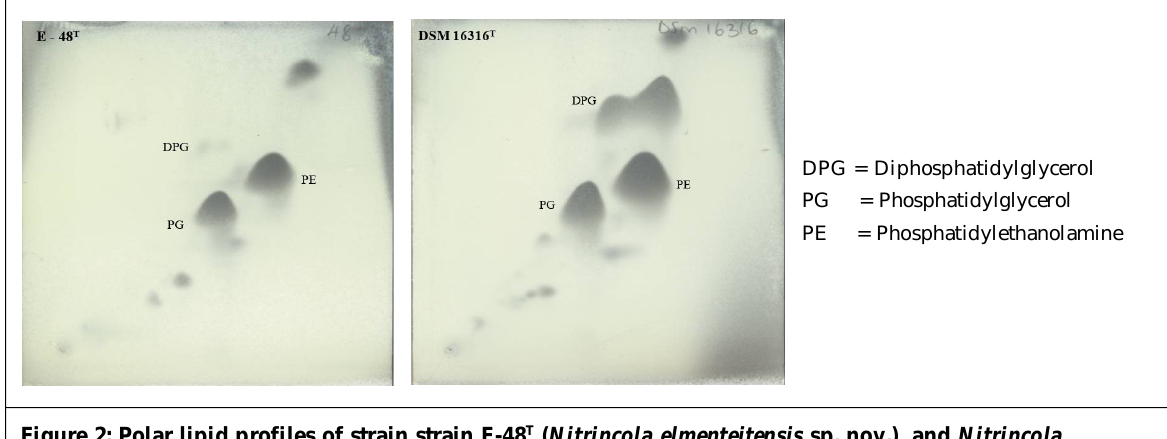
Figure 2: Polar lipid profiles of strain strain E-48 T ( Nitrincola elmenteitensis sp. nov.) and Nitrincola lacisaponensins DSM 16316 T after separation by two-dimensional TLC as described (Tindall 1990a; 1990b; Altenburgera et al., 1996)